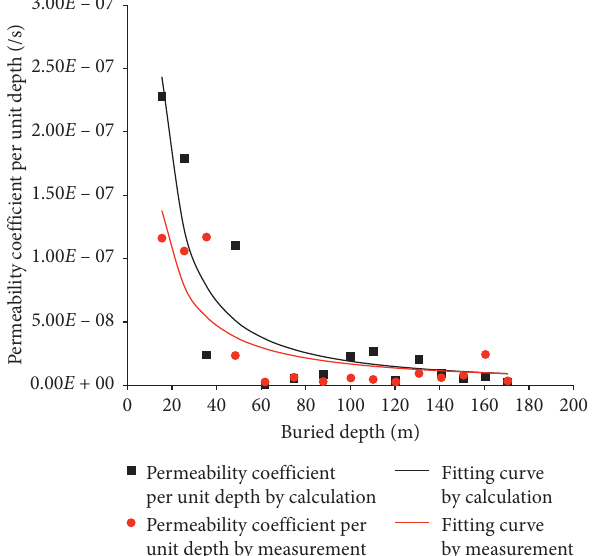
Figure 9: Comparison of fitting curves of the permeability coef- ficient per unit depth with buried